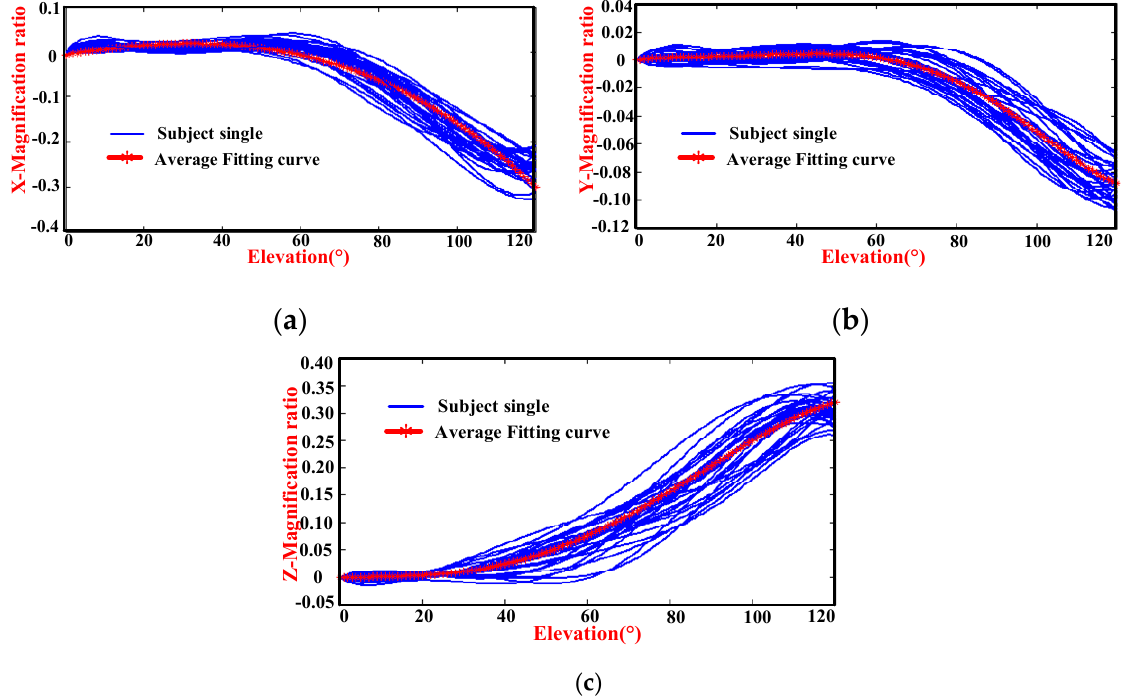
Figure 9. Diagrams of the magnification ratio of the GH joint center displacement variable quantity relative to the thorax coordinate system during humeral elevation in the coronal plane: ( a ) X- magnification ratio and elevation angle, ( b ) Y-magnification ratio and elevation angle, and ( c ) Z- magnification ratio and elevation angle.